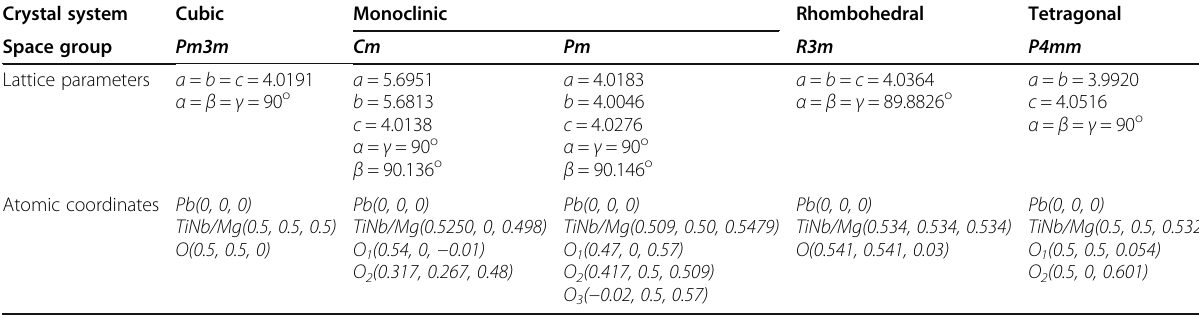
Table 1 Crystallographic information of PMN-31PT for cubic, monoclinic, rhombohedral, and tetragonal Crystal system